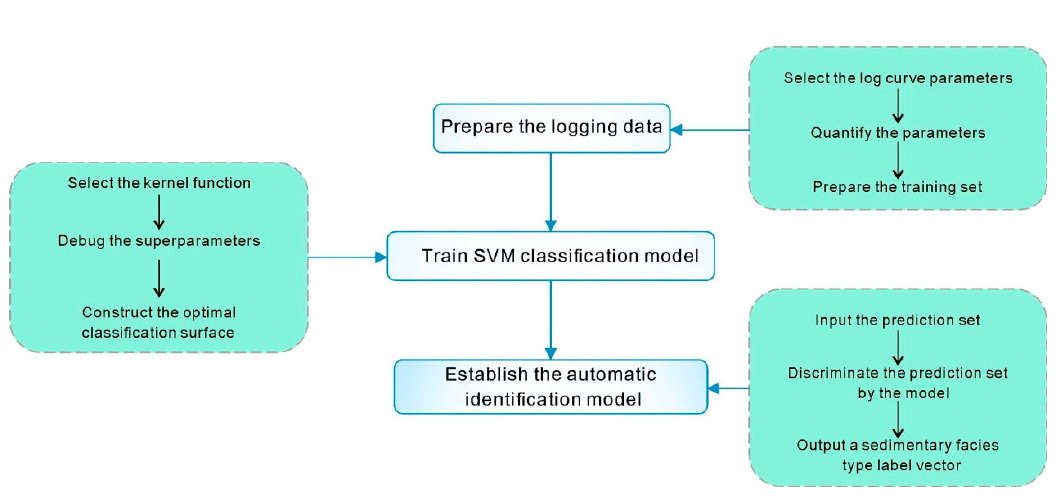
Figure 4. Conceptual framework for the modeling process [27,28].